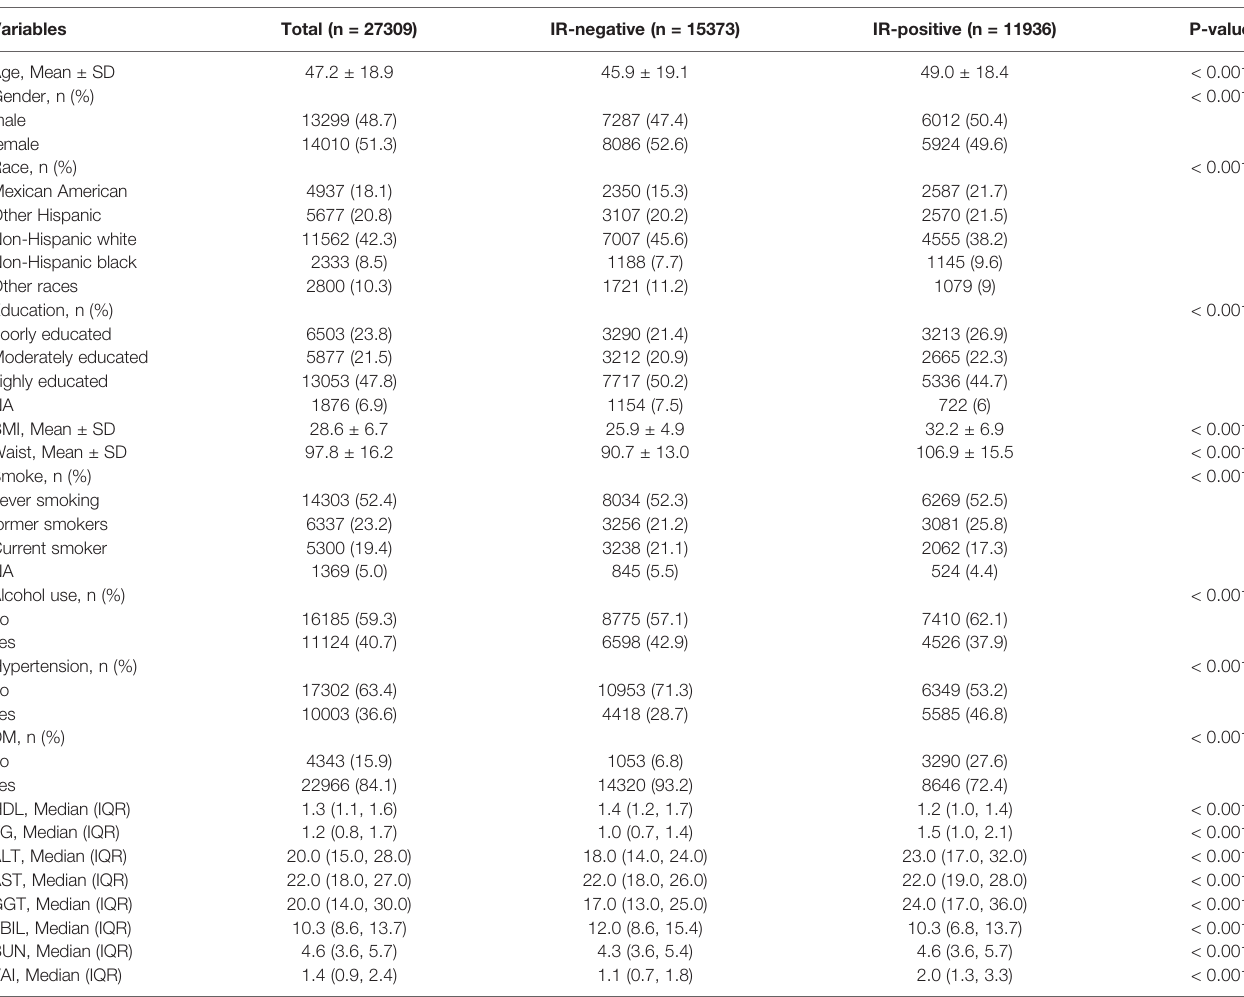
TABLE 1 | Basic crowd information description.